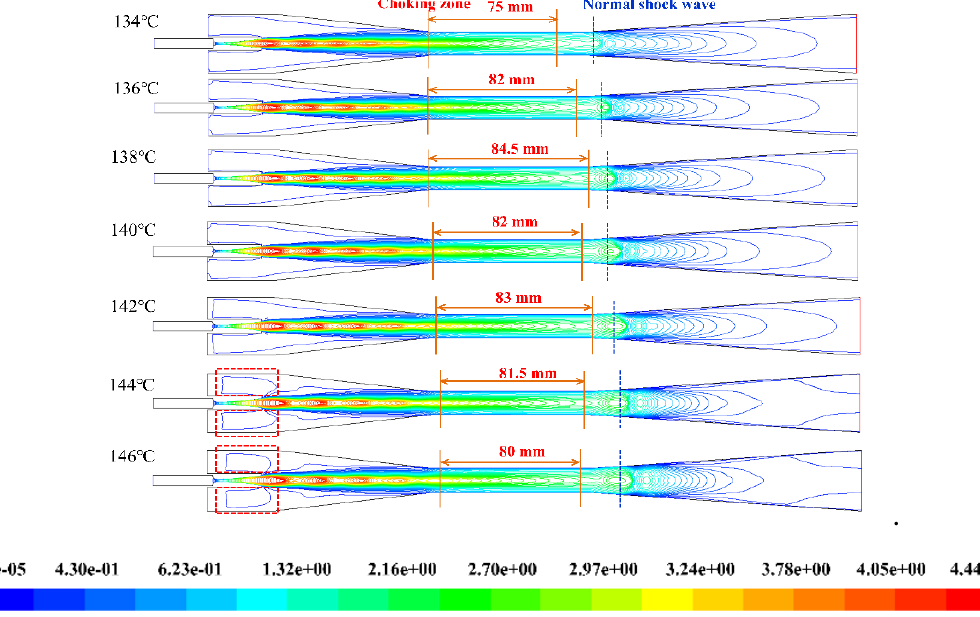
Figure 11. The contours of Mach number under various primary fluid temperature.